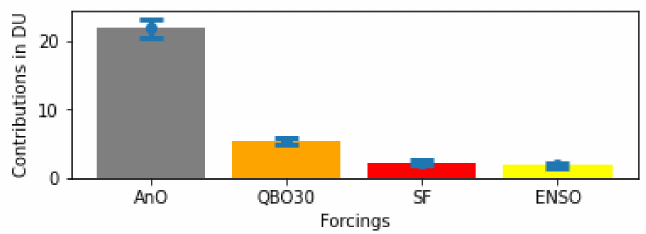
Figure 4. Significant forcings contribution at 2 σ , indicated by the error bars.